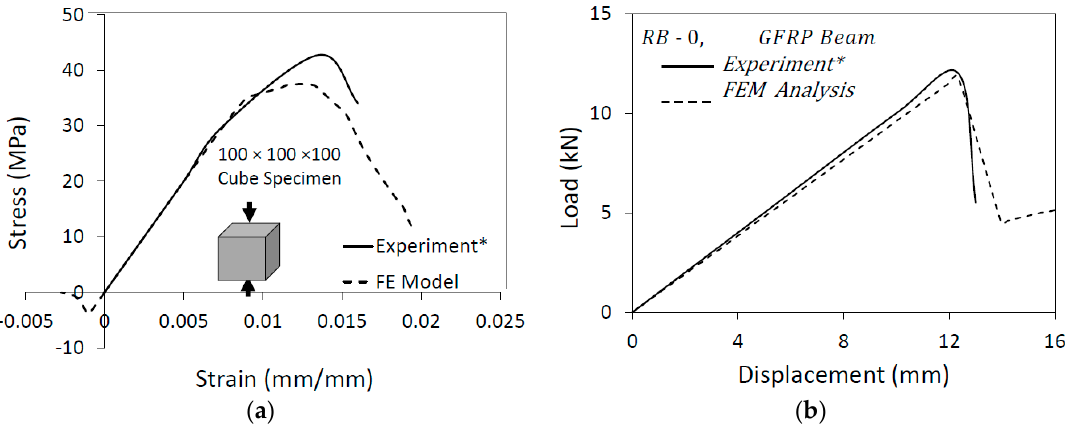
Figure 1. Verification of numerical material models with adopted experimental result * [28]: ( a ) Concrete Compression Results; ( b ) GFRP Beam Bending Results. Table 1. Nominal and numerical strength of the concrete.